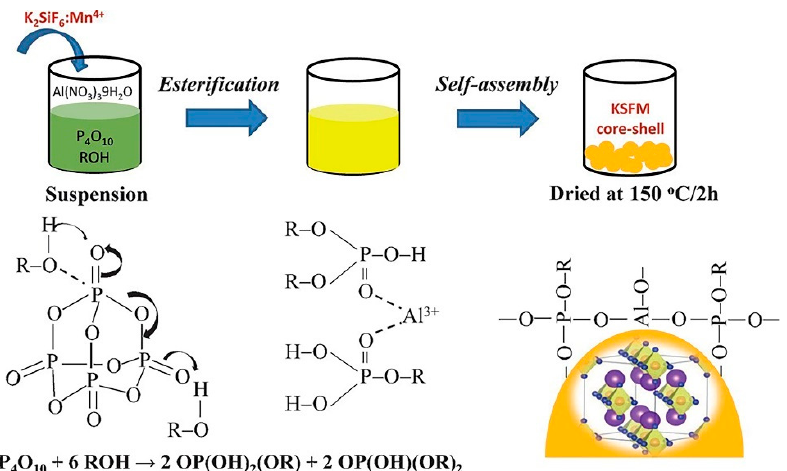
Figure 4. Formation of the alkyl phosphate layer on the K 2 SiF 6 : Mn 4+ surface. (Reprinted with permission from Ref [35]. Published by Angewandte Chemie, 2015).